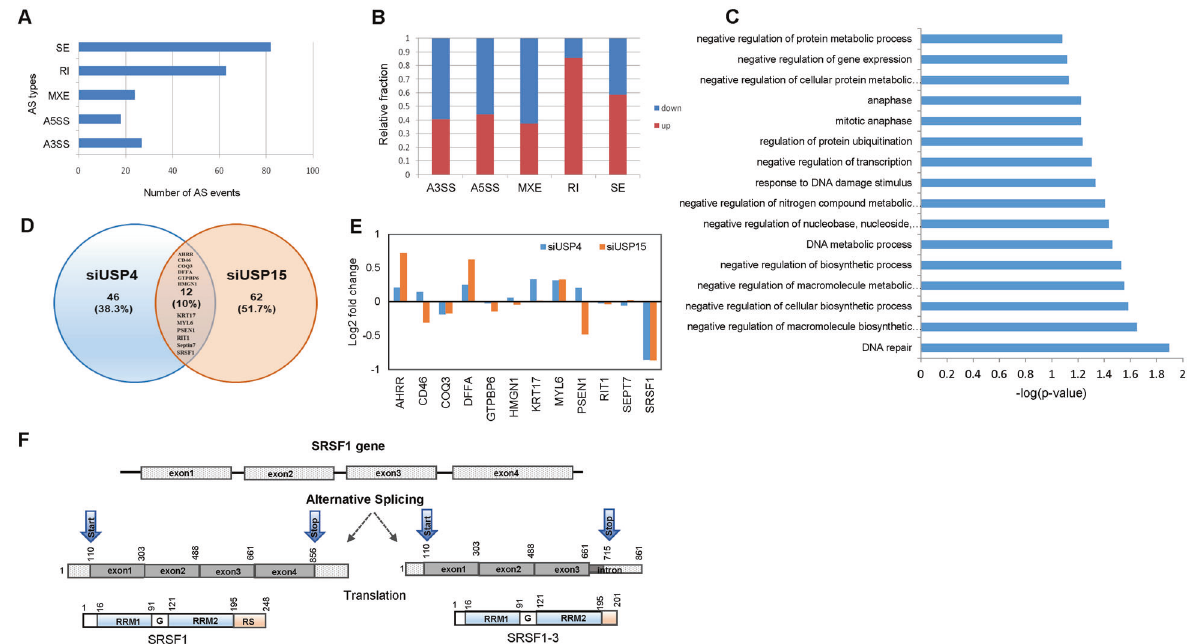
Fig. 2 Global changes in alternative splicing pattern by USP15 knockdown. A The percentage of alternative splicing events upon USP15 knockdown among the fi ve major types of alternative splicing (AS) event namely skipped exons (SE), alternative 5 ′ splice sites (A5SS), alternative 3 ′ splice sites (A3SS), retained introns (RI), and mutually exclusive exon usage (MXE) were displayed in the bar graph. B The relative fractions of genes upregulated or downregulated by the different alternative splicing events upon USP15 depletion are presented. C The alternatively spliced genes upon USP15 knockdown involved in diverse cellular pathways are classi fi ed and represented as distinct functional groups. D Venn diagram showing the common genes found to be regulated by both USP15 and USP4 knockdown. Twelve genes accounting for 10% of total genes whose intron retention was signi fi cantly regulated by knockdown of both USP15 and USP4 are listed. E A comparison of log 2 fold change of the identi fi ed common genes expression level is shown as the bar graph. F The gene sequence and alternatively spliced isoforms of SRSF1 are schematically